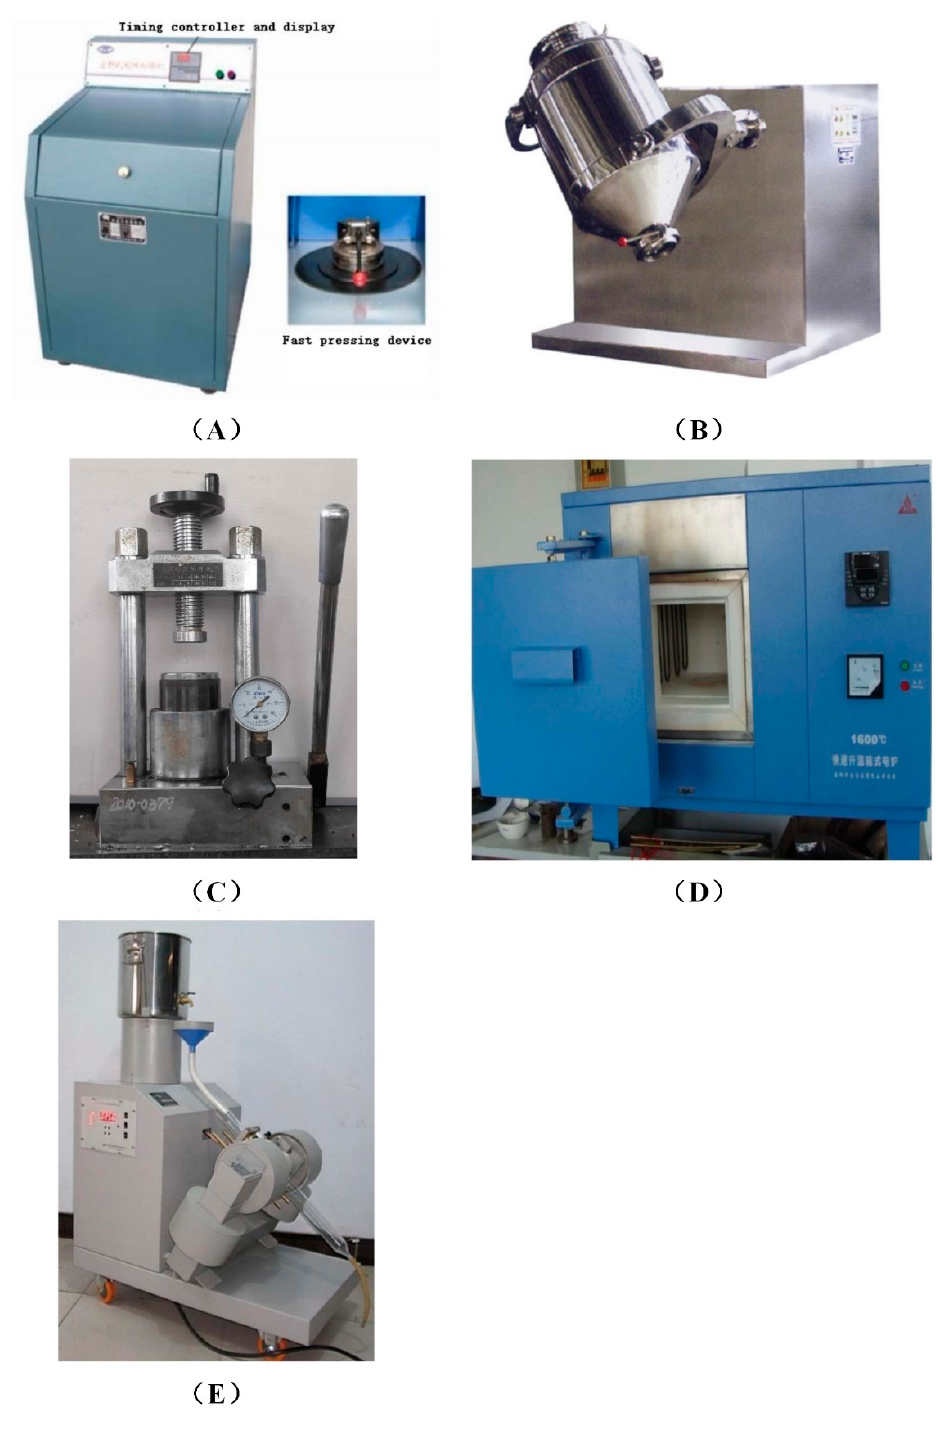
Figure 3. Experimental devices. ( A ) Grinder; ( B ) mixer; ( C ) presser; ( D ) muffle furnace; ( E ) mag- netic separator.